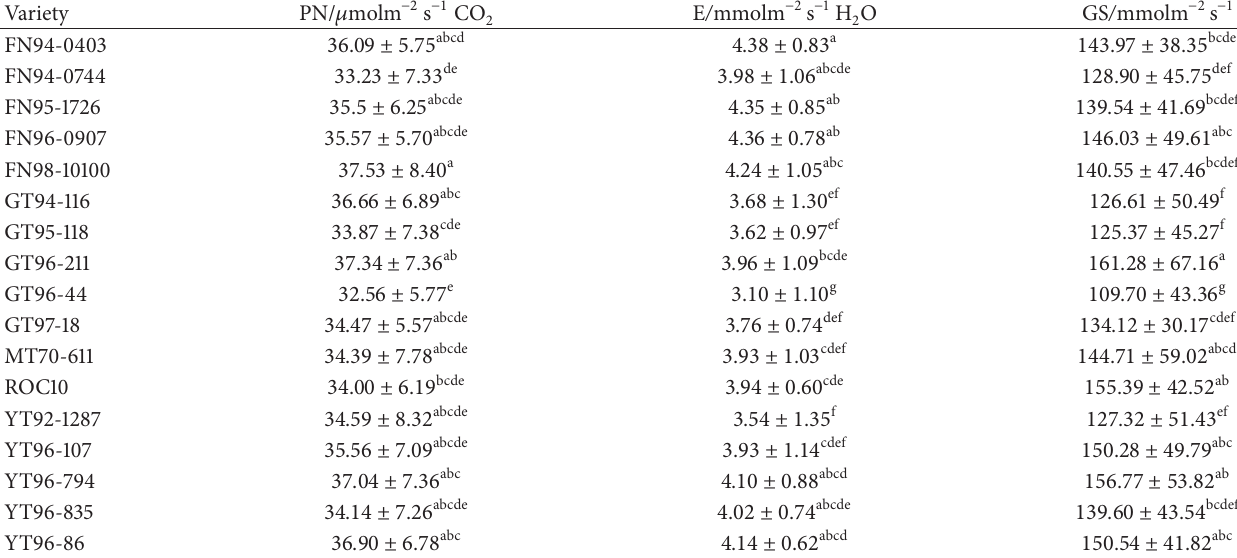
Table 2: Photosynthesis rate (PN), transpiration rate ( 𝐸 ), and stomatal conductivity (GS) of 17 sugarcane varieties. Variety